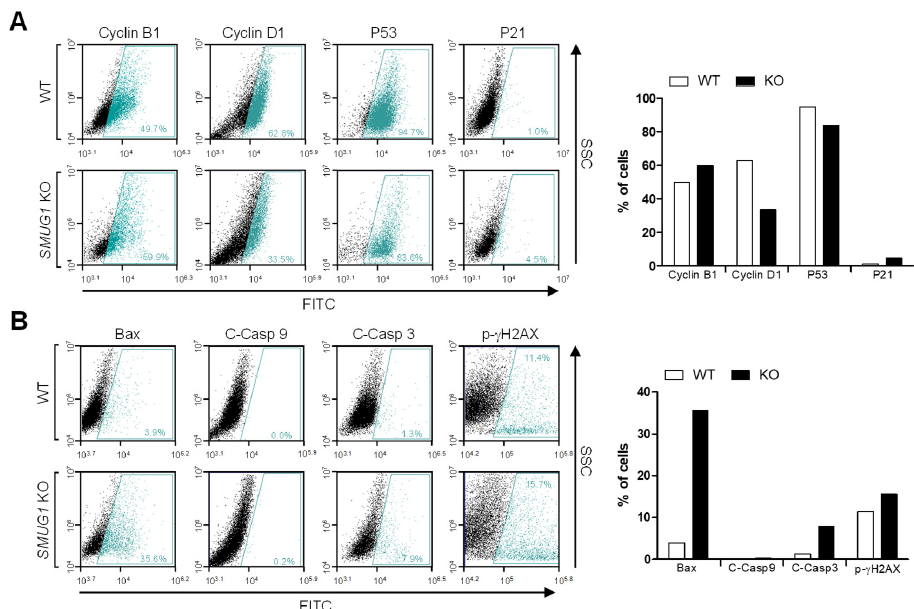
Figure 5. SMUG1 knock-out inhibits cell proliferation and induces apoptosis. ( A ) Flow cytometry using Cyclin B1, Cyclin D1, P53, and P21 antibodies for the cell cycle and apoptosis analysis of HepG2 WT and SMUG1 KO cells was performed. ( B ) Flow cytometry using BAX, cleaved caspase 9 (active form), and cleaved caspase 3 (active form) staining for active apoptosis and phosphorylated H2AX for DNA damage response of HepG2 WT and SMUG1 KO cells was